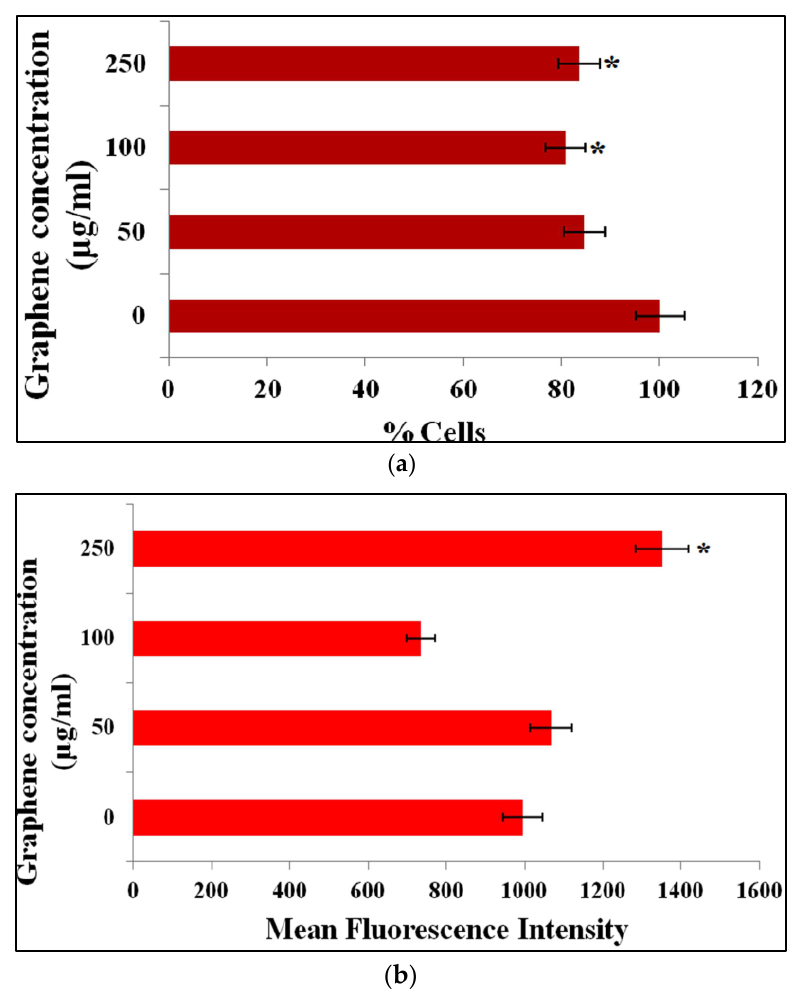
Figure 17. ( a ) Neural red uptake and ( b ) flow cytometry (PI estimation) results for green synthesized rGO exposed to human lymphocyte cells. Reproduced from [105] with permission of Public Library of Science.